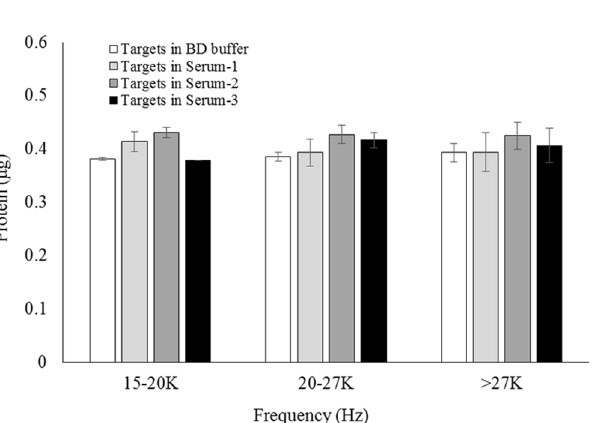
Figure 5. Standard calibration curve for target molecules using the MP-1 aptamer as a capture ligand by q-PCR, the relative expression level vs. ( a ) CRP, ( b ) HBs Ag, and ( c ) HCV NS3 quantities in BD buffer.